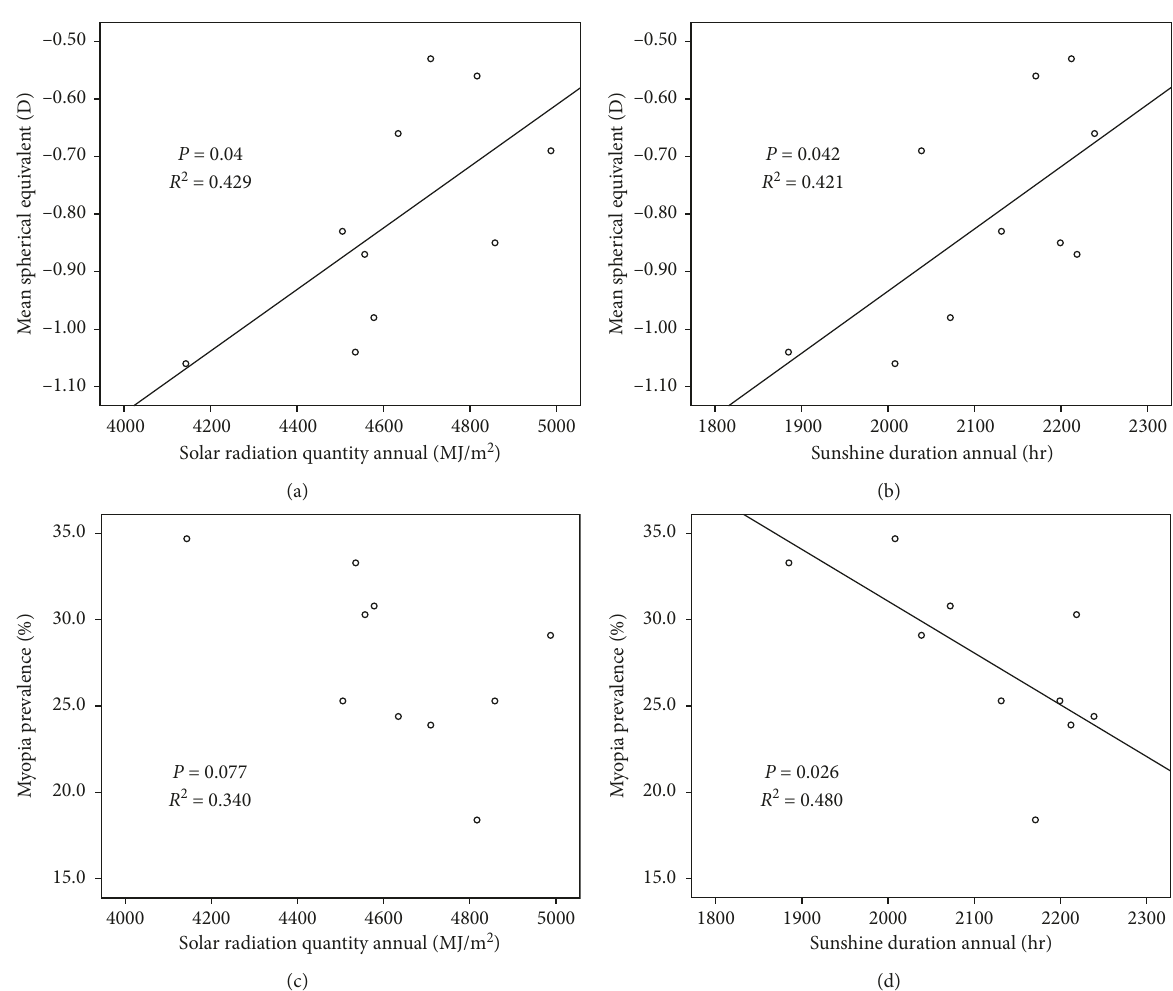
SE, spherical equivalent.